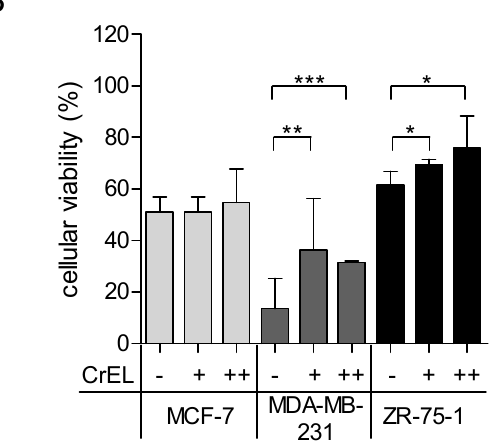
Figure 4. ( A ) Competition of doxorubicin and CrEL in HEK293-OATP1A2 and MDCKII-OCT1, -OCT2, -and OCT3 cells after incubation with doxorubicin (10 µ M for OATP1A2, 50 µ M for OCTs) in presence (+) or absence ( − ) of CrEL and an incubation time of 2 min (OCTs) or 3 min (OATP1A2). ( B ) Cell viability assay in in breast cancer cell lines after incubation with 100 µ M doxorubicin for 72 h in presence (+/++) or absence ( − ) of CrEL (+, 10 − 4 %; ++, 10 − 2 %). Viability was compared to cells incubated with DMSO as solvent for doxorubicin (=100%) (data gives as mean ± SD; n = 3; * p < 0.05; ** p < 0.01; *** p < 0.001).